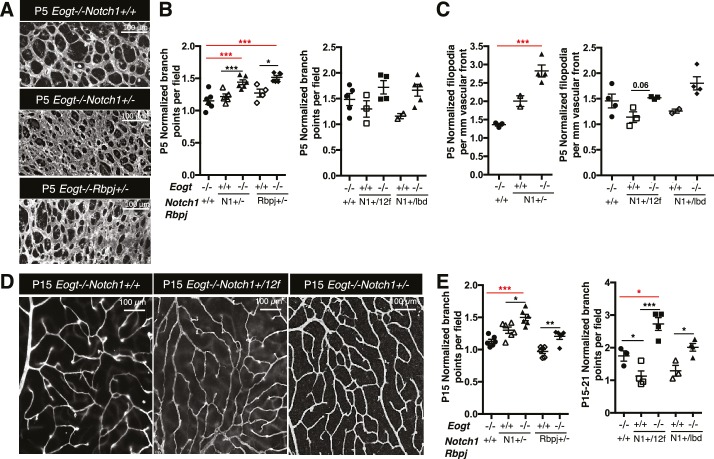
Reduced Notch signaling augments the loss of Eogt in retinal angiogenesis.(A) Images of vessel density in P5 retinas from Eogt−/− compared to compound mutant mice. (B) Scatter plots represent branch point numbers in P5 retinas from Eogt−/− compared with compound mutant mice, normalized to Eogt+/+ mice. The average number of branch points for the Eogt+/+ used to compare mice with an N1− or Rbpj− allele was 237 ± 5, and for the Eogt+/+ compared to mice with an N12f or N1lbd allele was 380 ± 36 (500 X 500 μm field (n = 3–8 fields per retina), N = 2–6 mice). (C) Scatter plots showing the number of filopodia in P5 compound mutant mice as compared to Eogt−/− mice, normalized to Eogt+/+ mice. Each symbol represents the average number of filopodia per mouse (250 × 250 µm field (n = 4–12 fields per mouse), N = 2–4 mice. The average for Eogt+/+ compared to mice with a N1- or Rbpj- allele was 30 ± 1 per mm and for mice with a N112f or N1lbd allele was 36 ± 4 per mm, taken as 1.0 for normalization. (D) Images of branch points in P15 retinas comparing Eogt−/− to compound mutant mice as indicated. (E) Scatter plots shows branch points in compound mutants compared to Eogt−/− P15 retinas, normalized to Eogt+/+ mice. The average of the Eogt+/+ used to compare mice with a with a N1− or Rbpj− allele was 73 ± 3, and for mice with a N112f or N1lbd allele it was 69 ± 12 (500 x 500 µm field (n = 3–8 fields per retina), N = 3–6 mice. Data represent mean ± standard error except for P5 Eogt+/+Notch1+/− filopodia and P5 Eogt+/+Notch1+/lbd branch points and filopodia that are represented as mean ± range; p values were calculated by unpaired two-tailed Student’s t-test. *p≤0.05; **p≤0.01; ***p≤0.001.